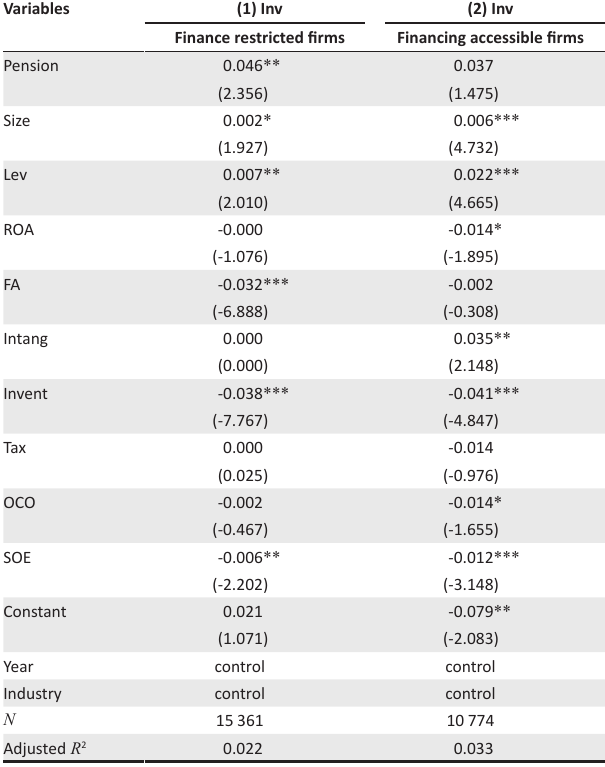
TABLE 10: Financing-adjusted test. Variables (1) Inv (2) Inv Finance restricted firms